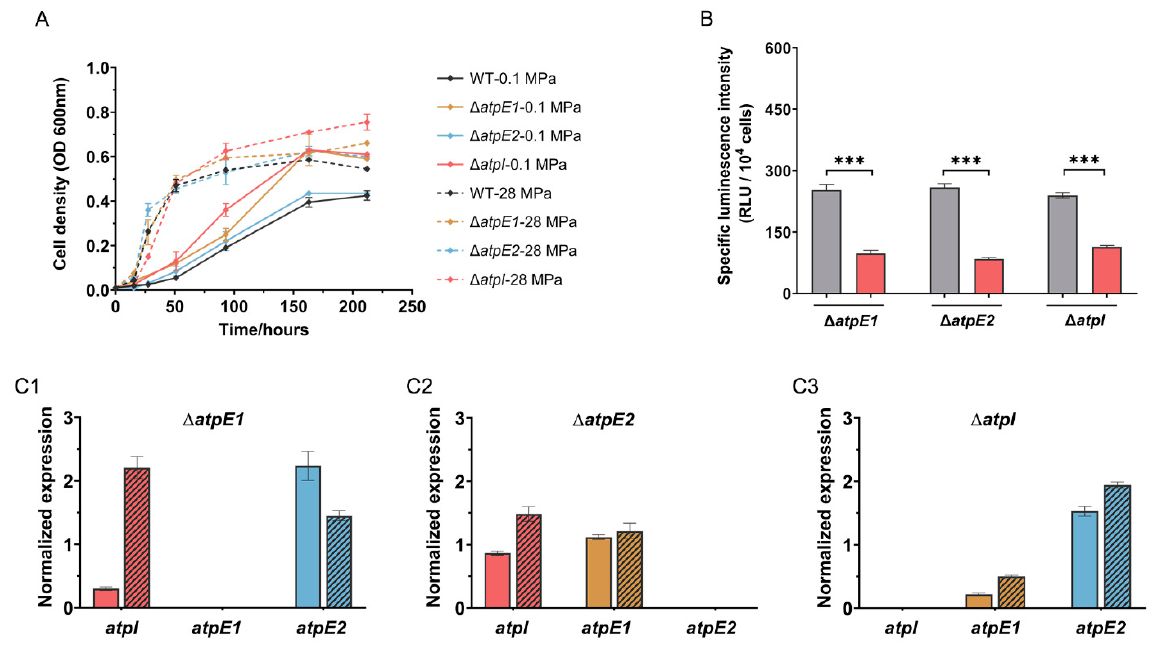
Figure 5. The growth curves, intracellular ATP level and expression of ATPase in ∆ atpE 1, ∆ atpE 2 and ∆ atpI mutants grown in MG medium. Panel ( A ), growth curves of wild-type and mutant strains at different pressures. Panel ( B ), specific intracellular ATP level in different mutants. The grey and red bars represent cultures at 0.1 MPa and 28 MPa, respectively. Panel ( C1 – C3 ), expression of atpI , atpE 1 and atpE 2 in the mutants relative to the wild-type strain. The colored bars represent relative expression at 0.1 MPa, and colored bars with shadows represent relative expression at 28 MPa. Panels C1, C2 and C3 show the mutant of ∆ atpE 1, ∆ atpE 2 and ∆ atpI , respectively. The statistical analysis of comparisons between two groups was performed using an unpaired-sample t -test: ***, p < 0.001.